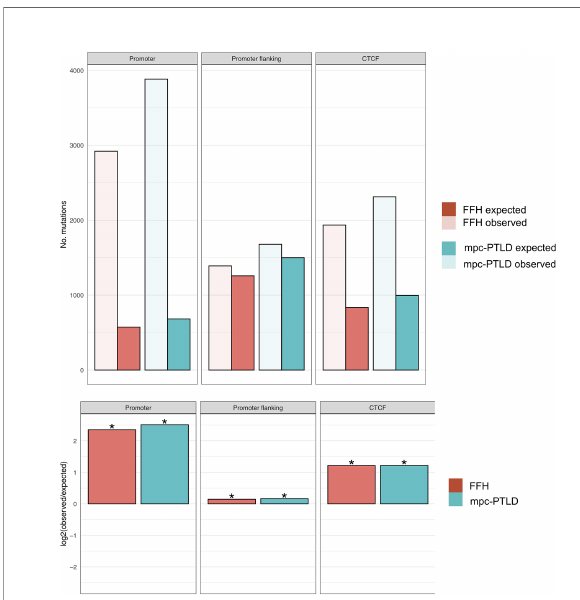
FIGURE 7 | Analysis of the immune cell composition within (A) the FFH- PTLD cases and (B) the monomorphic, polymorphic, and classic Hodgkin (mpc)-PTLD cases based on gene expression pro fi le. EBV positive cases are circled in